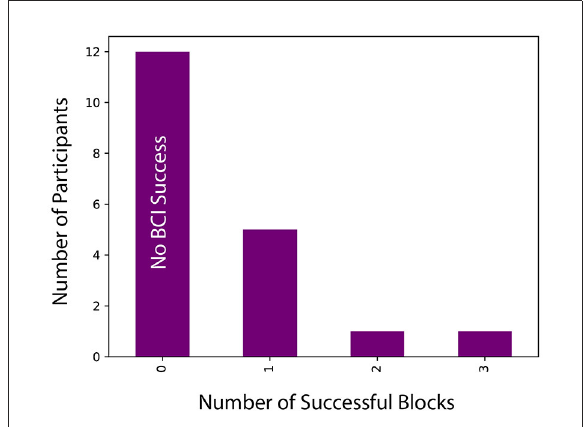
FIGURE8 Distribution of successful blocks across participants.